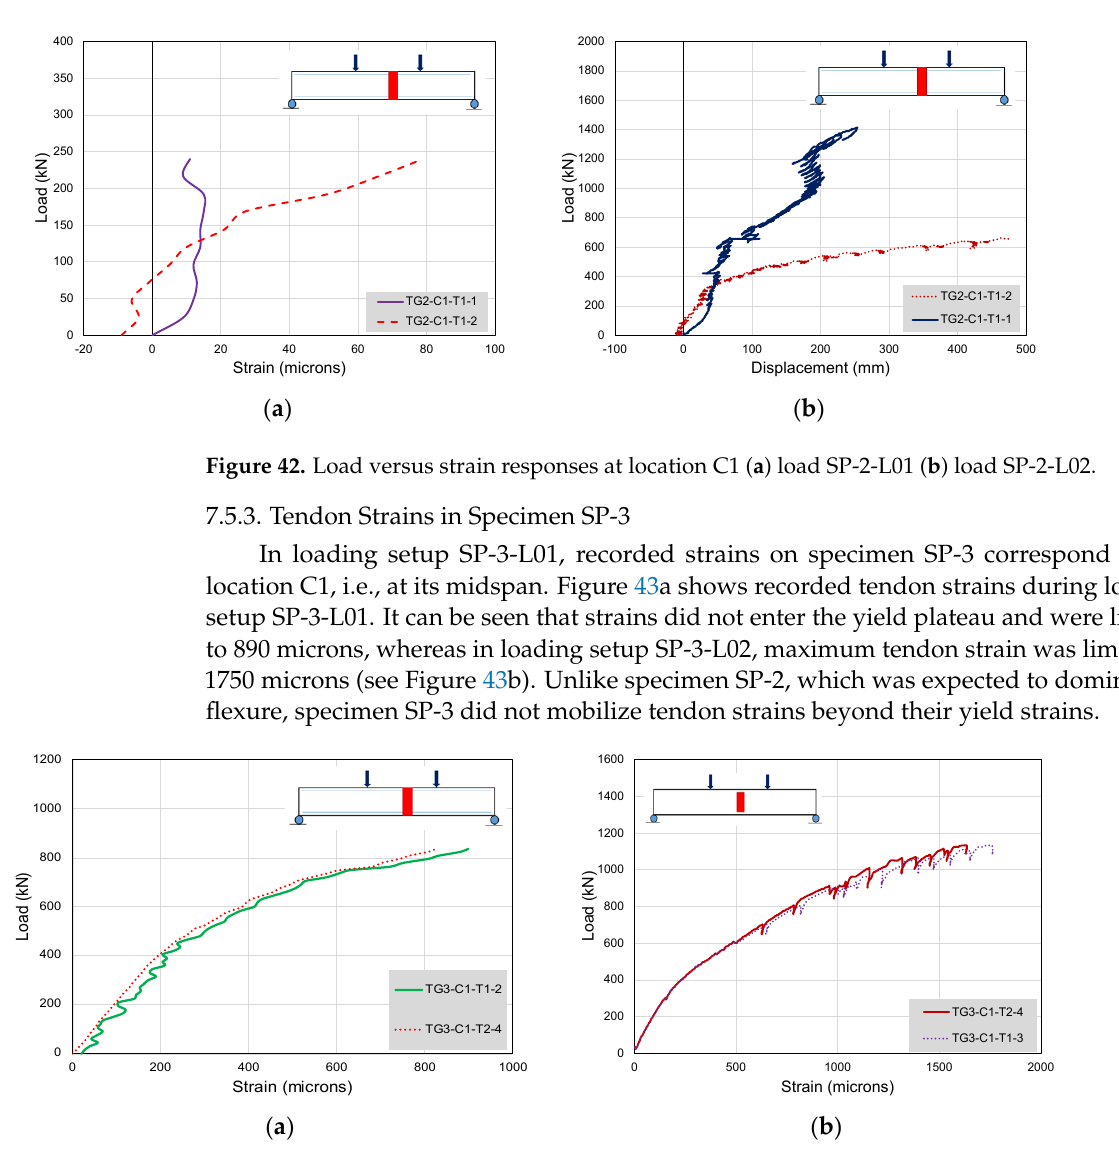
Figure 41. Tendon strains recorded during loading setup SP-1-L04 at locations ( a ) C1, ( b ) A2, ( c ) C2, and ( d ) A3.